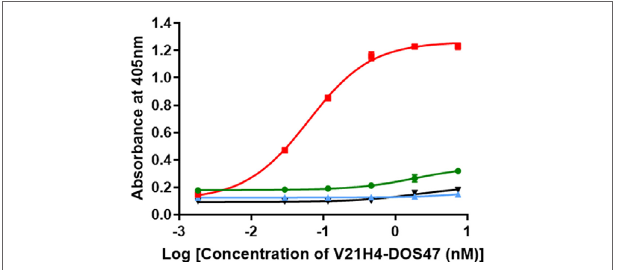
FigUre 9 | ELISA of V21H4-DOS47 binding to VEGFR1, VEGFR2, and VEGFR3. Green line is VEGFR1. Red line is VEGFR2. Blue line is VEGFR3. Black line is no VEGFR. Results shown are representative of two experiments performed for each sample and are presented as the means and SE of samples tested in